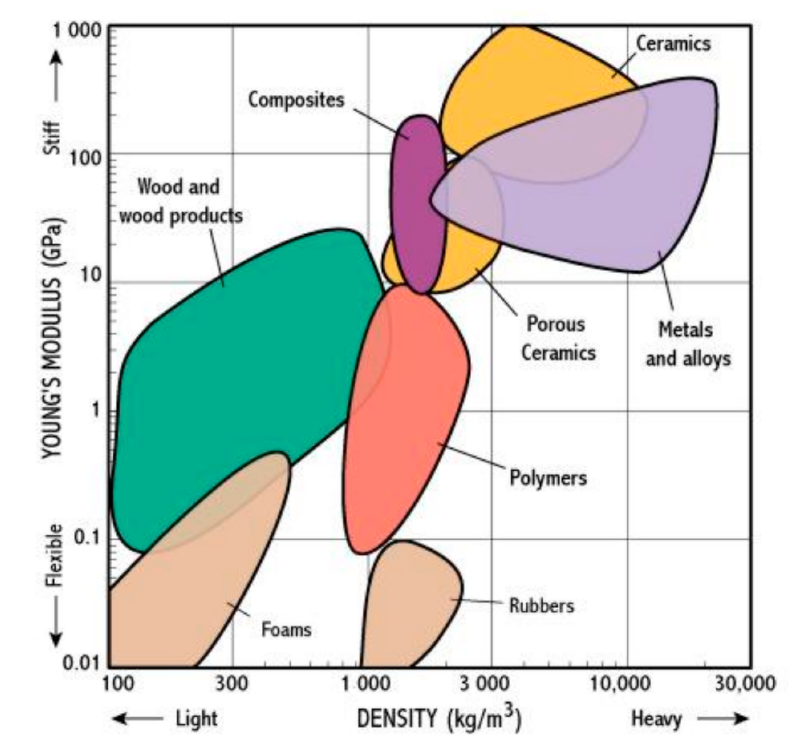
Figure 3. Ashby chart